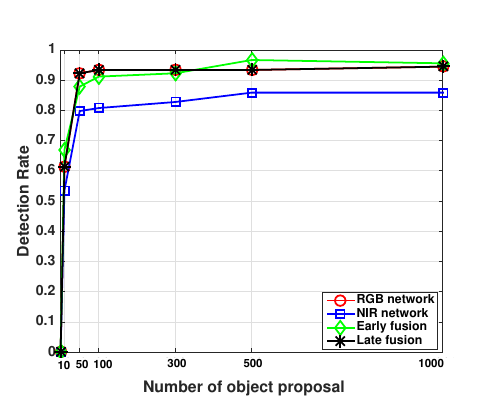
Figure 10. Performance evaluation of the region proposals of four different networks.